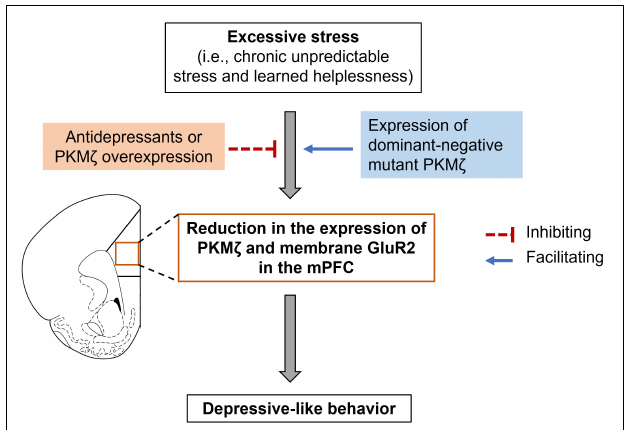
FIGURE 2 | PKM ζ in the mPFC participates in stress-induced depressive-like behaviors. Excessive stress, such as chronic unpredictable stress and learned helplessness, could lead to a reduction in PKM ζ and membrane GluR2 expression in the medial prefrontal cortex (mPFC) as well as depressive-like behavior. Antidepressants or virus-mediated expression of PKM ζ in the mPFC could relieve the depressive-like behavior. In contrast, virus-mediated expression of dominant-negative mutant PKM ζ facilitated subthreshold CUS-induced depressive-like